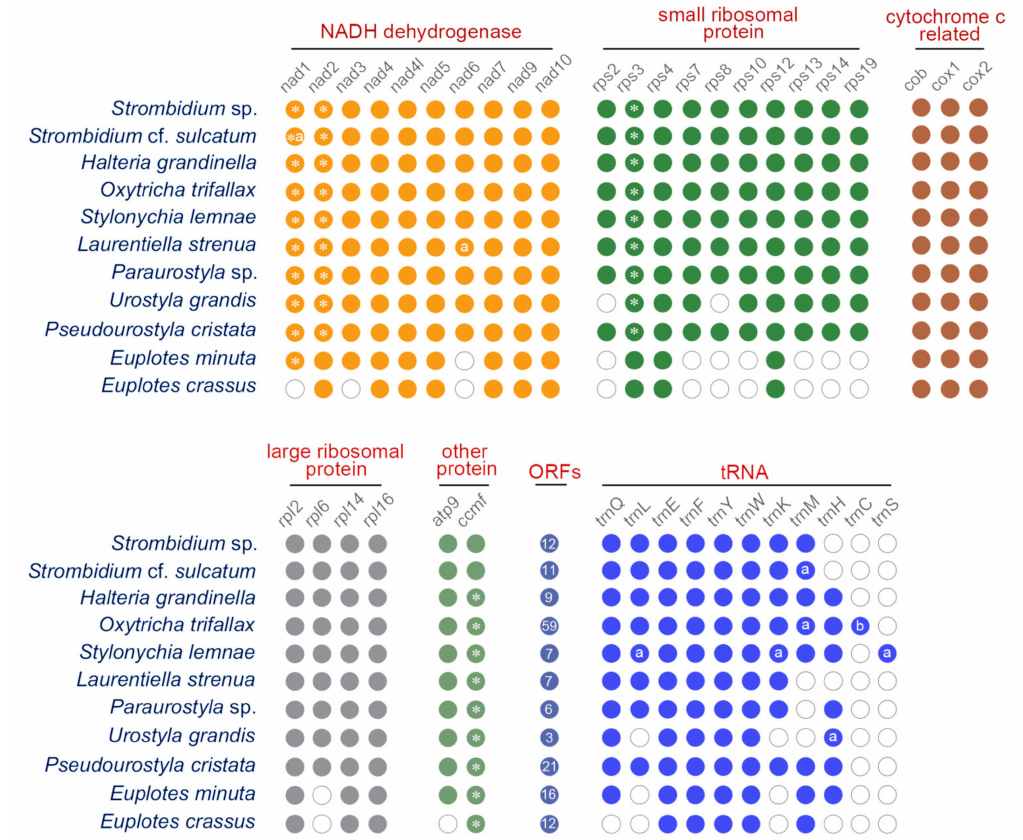
Figure 2. Protein and tRNA genes encoded in mitogenomes of the class Spirotrichea. The solid circles represent presence and the hollow circles represent absence. The asterisk “*” indicates a split gene that is split into two parts. The letter “a” indicates the gene is duplicated into two copies, while “b” represents that one copy of tRNA_Cys ( trnC ) is a pseudogene. The number indicates the number of unknown